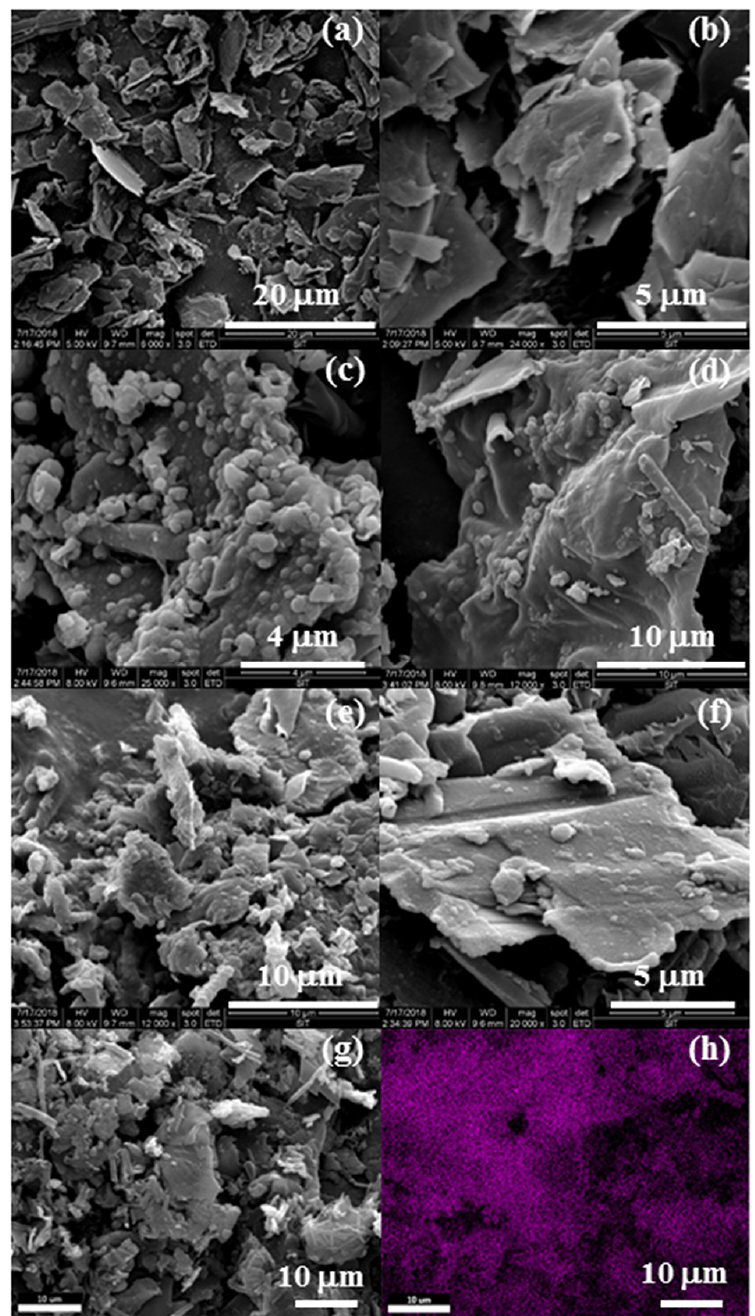
Figure 3. Scanning electron microscopy (SEM) ( a ) images of graphite (20 um) and ( b ) images of graphite (5 um), graphite/PEDOT nanocomposites with 8.9 wt % ( c ), 18.1 wt % ( d ), 29.8 wt % ( e ), and 37.2 wt % ( f ) graphite. SEM image ( g ) and corresponding energy dispersive spectrometer (EDS)-mapping of sulphur ( h ) for the graphite/PEDOT nanocomposites with 37.2 wt % graphite.